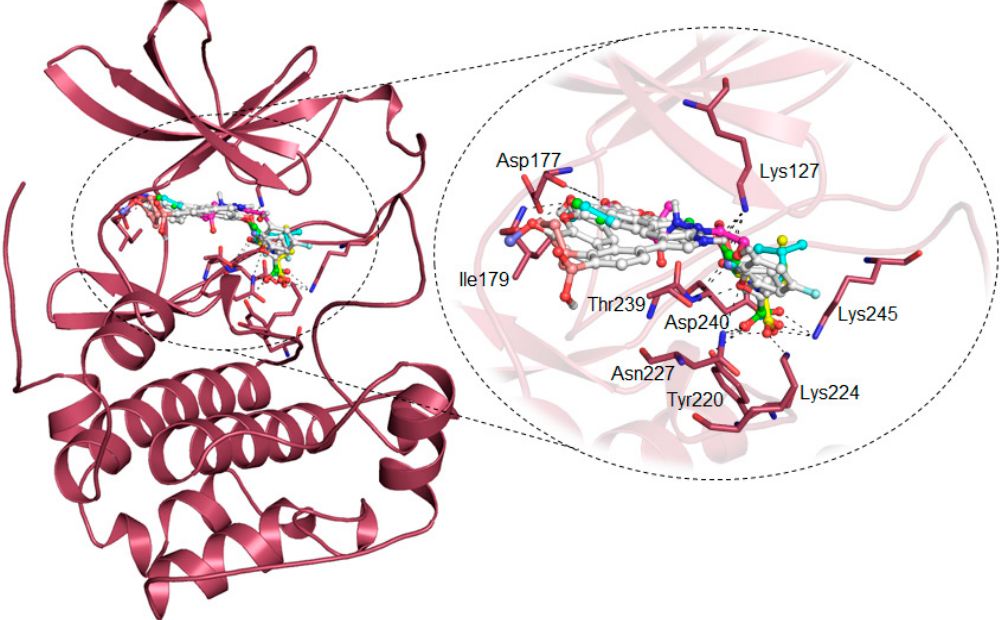
Figure 2 . Cartoon representation of SGK1 in-complex with compound ZINC00319000 (green element), ZINC02106991 (cyan element), ZINC02115387 (yellow element), ZINC02121074 (blue element), EMD638683 (magenta element), and GSK650394 (red element).